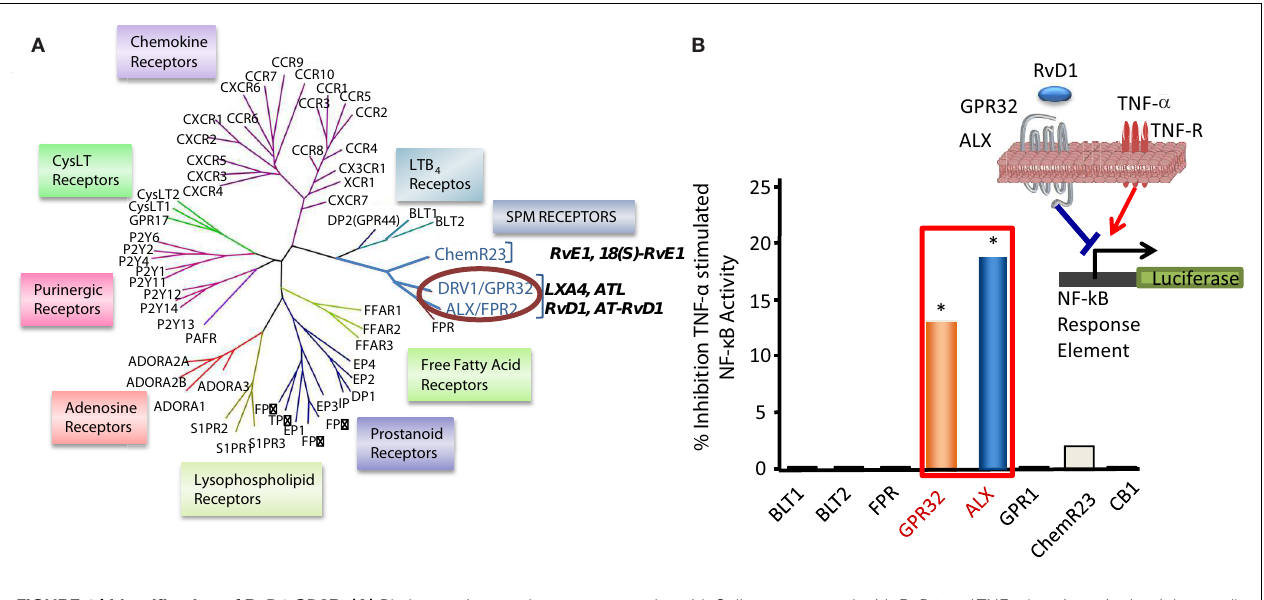
FIGURE 4 | Identification of RvD1 GPCR. (A) Phylogenetic tree shows similarities in the amino acid sequences of human GPCRs closely related to LXA 4 , RvE1, and LTB 4 receptors (left panel). Cluster was generated with the ClustalW2 software (www.ebi.ac.uk/Tools/clustalw2). Protein sequences were deduced from the NCBI database and receptor nomenclature followed the IUPAR classification for GPCR. (B) For functional screening and identification of RvD1 receptor, GPCRs were cloned in pcDNA3 vector and overexpressed in human HeLa cells cotransfected with pNF- κ B luciferase